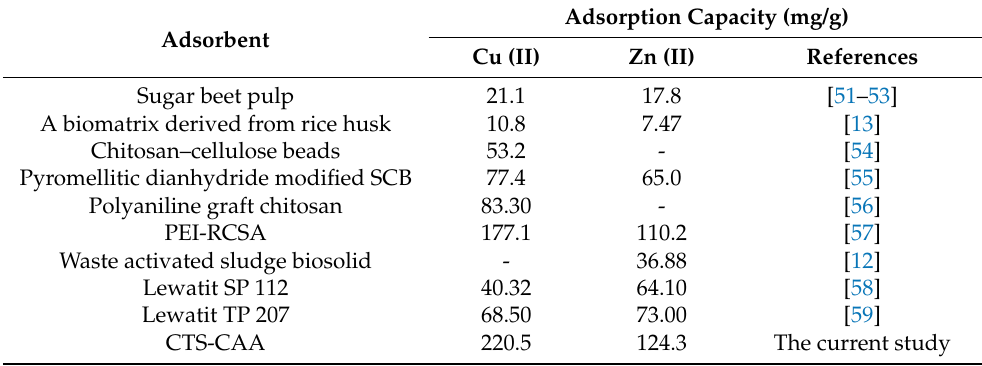
Table 4. Disparity of the adsorption capacities of different adsorbents for the separation of Cu (II) and Zn (II) from their aqueous